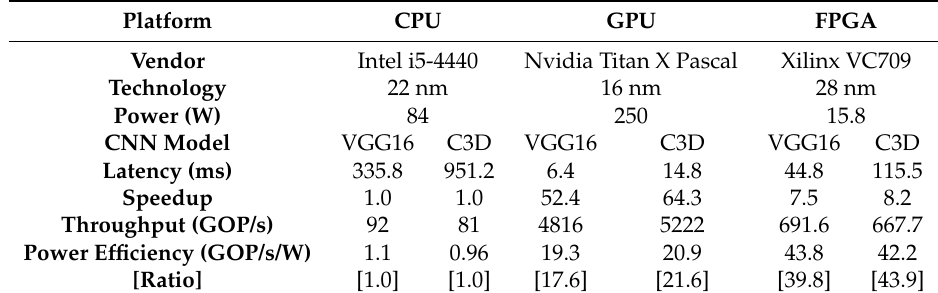
Table 4. Evaluation results on the central processing unit (CPU), graphics processing unit (GPU), and our